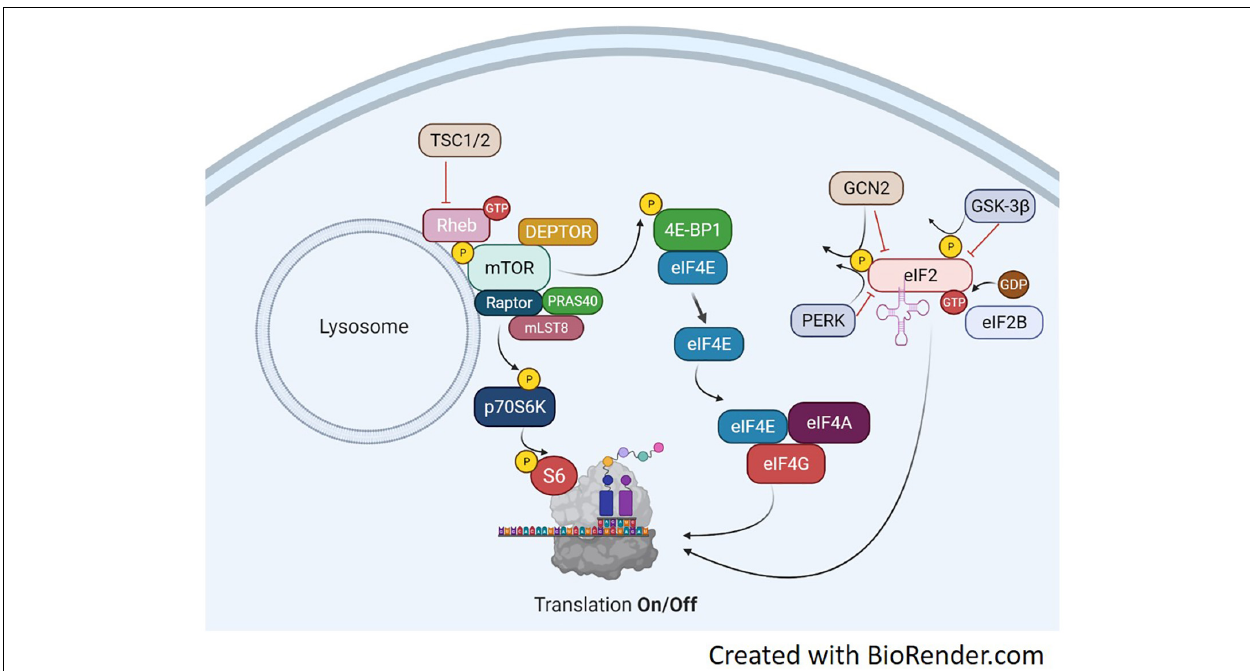
FIGURE 1 | Translation Overview. Protein translation occurs, in part, by mTORC1-dependent regulation of p70S6K and the 4E-BP1/eIF4E complex and the mTORC1-independent eIF2 complex. mTORC1 activation is achieved through several points of regulation including, but not limited to phosphorylation at ser2448, inactivation of the TSC1/2 complex, binding of GTP-bound RHEB and translocation to the lysosome. Upon activation, mTORC1 will phosphorylate p70S6K at Thr389. This activates p70S6K to phosphorylate ribosomal protein S6 at ser236/236 and initiate RNA translation. mTORC1 can also regulate the eIF4E complex by phosphorylating 4E-BP1 which results in detachment of 4E-BP1 from eIF4E. This frees eIF4E to bind with eIF4A and eIF4G which will initiate binding of mRNA to the ribosome. A third point of translation initiation is the eIF2 complex. eIF2 forms a ternary complex with GTP and the Met-rRNA binds to the 40S ribosomal subunit to start the translation process. Its regulation is mediated through phosphorylation by various kinases including GSK-3 β , PERK, and GCN2. Phosphorylation of eIF2 inhibits the guanine nucleotide exchange function of eIF2B and prevents